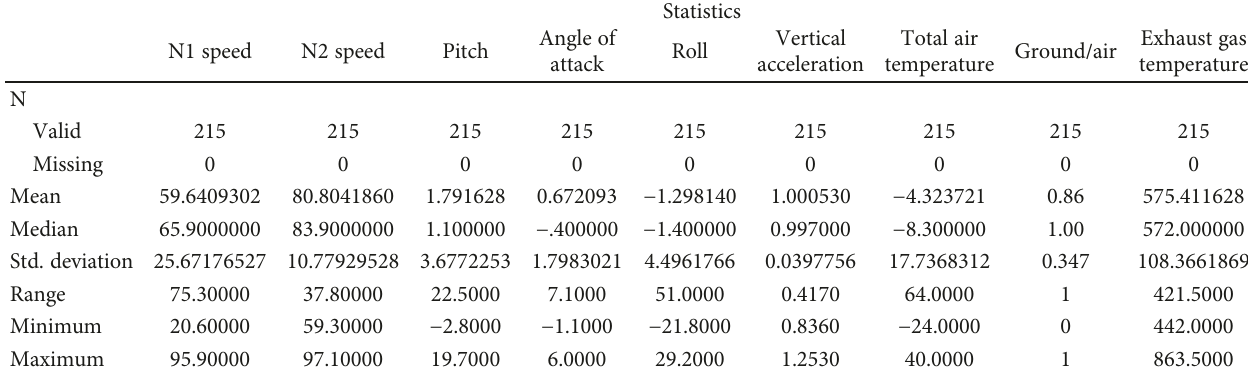
Table 4: Validation data range used in the prediction of